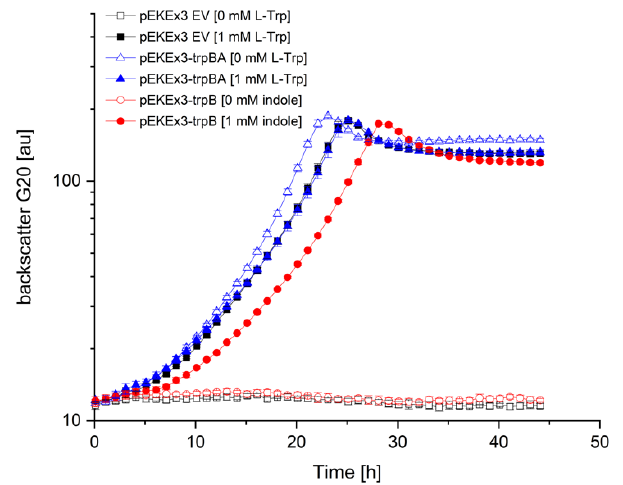
Figure 4. Growth of C. glutamicum C1* Δ trpBA deletion mutant strain in standard CGXII